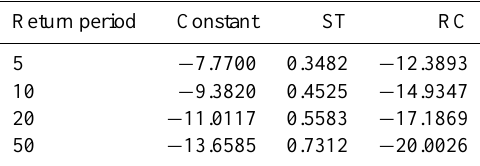
Table 5. Regression coefficients of the model for re- gion Fig. 4. Map of homogeneous regions and agro-geographical regions in Wallonia. The four homogeneous regions nearly correspond to Walloon agro-geographical